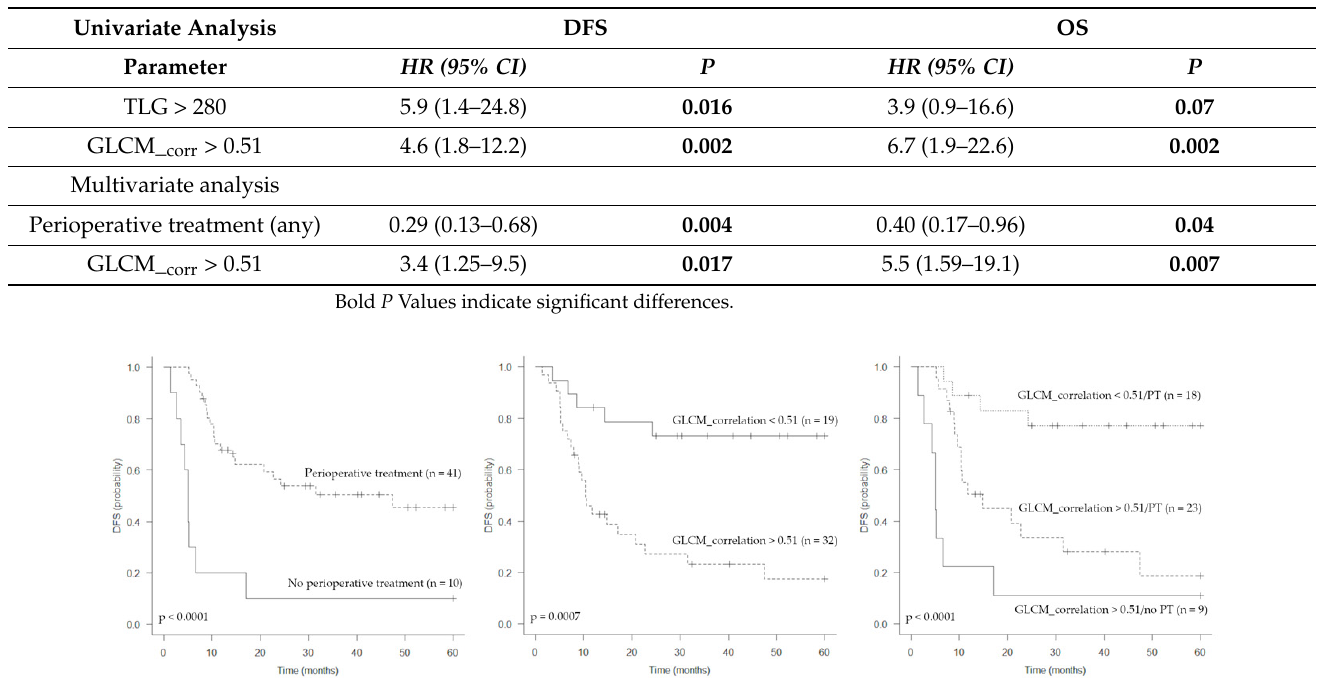
Figure 3. Kaplan–Meier estimations of disease-free survival (DFS) according to perioperative treatment, GLCM_correlation and both parameters combined.